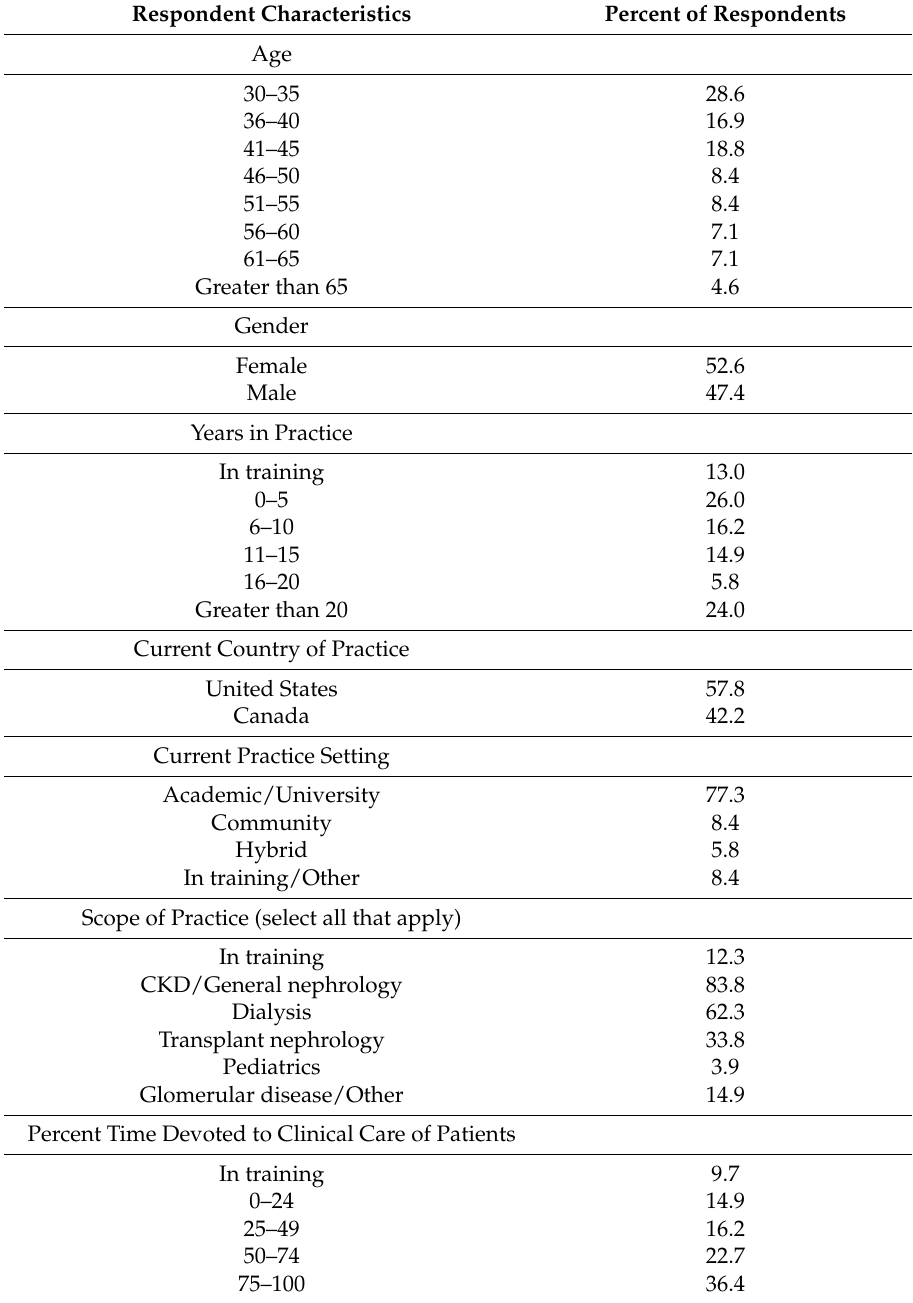
Table 1. Survey Respondent Characteristics ( n =